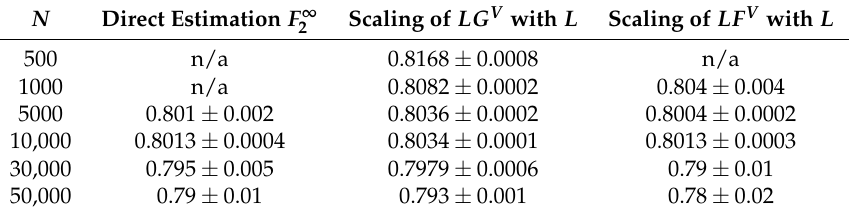
Table 5. Surface term in the thermodynamic limit F ∞ for a WCA system at T = 2 and ρ = 0.6 (dimensionless units). Values of F ∞ are computed from systems with various number of particles N and using the different methods listed in Table 2.